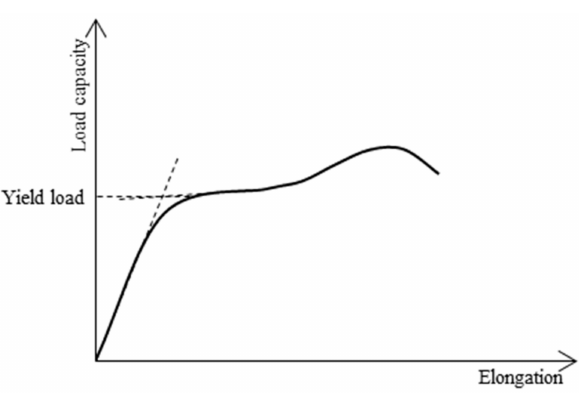
Figure 8. Experimental load-displacement curves.